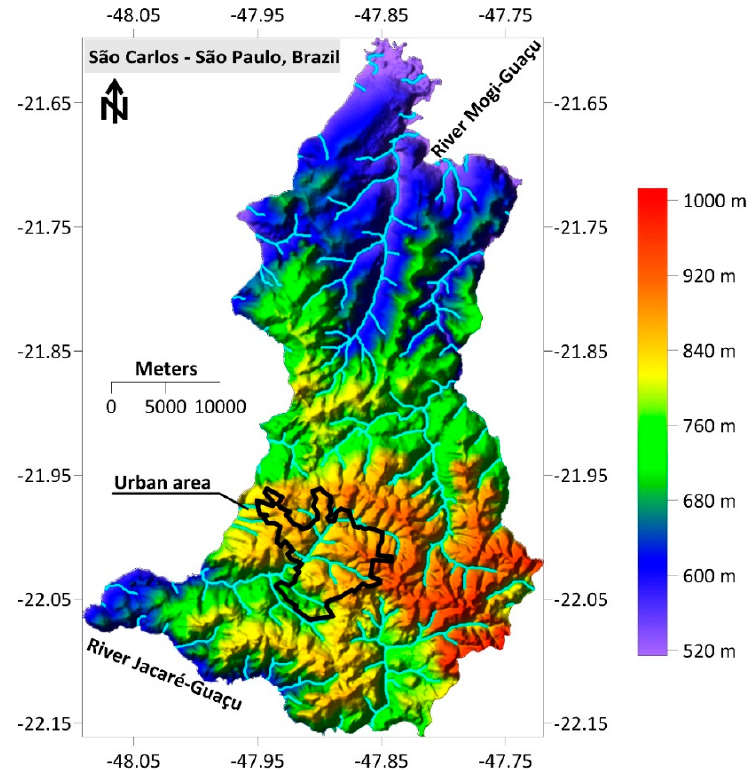
Figure 1. Hypsometric map of São Carlos.